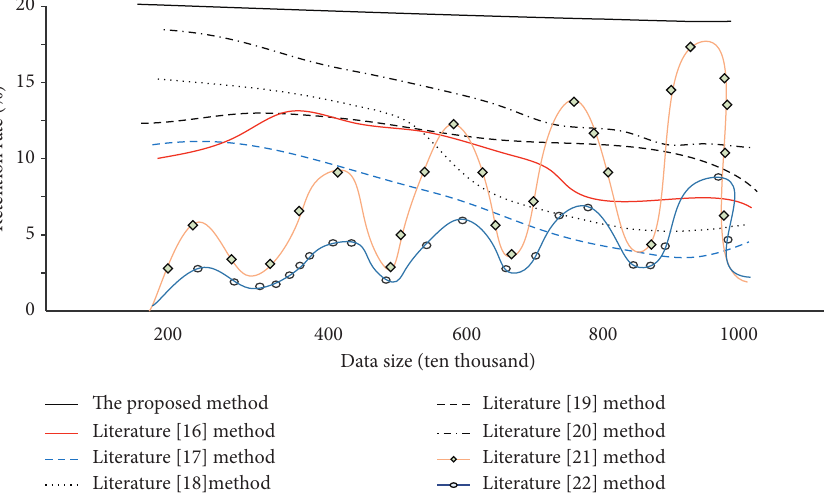
Figure 7: Data update rate change results.